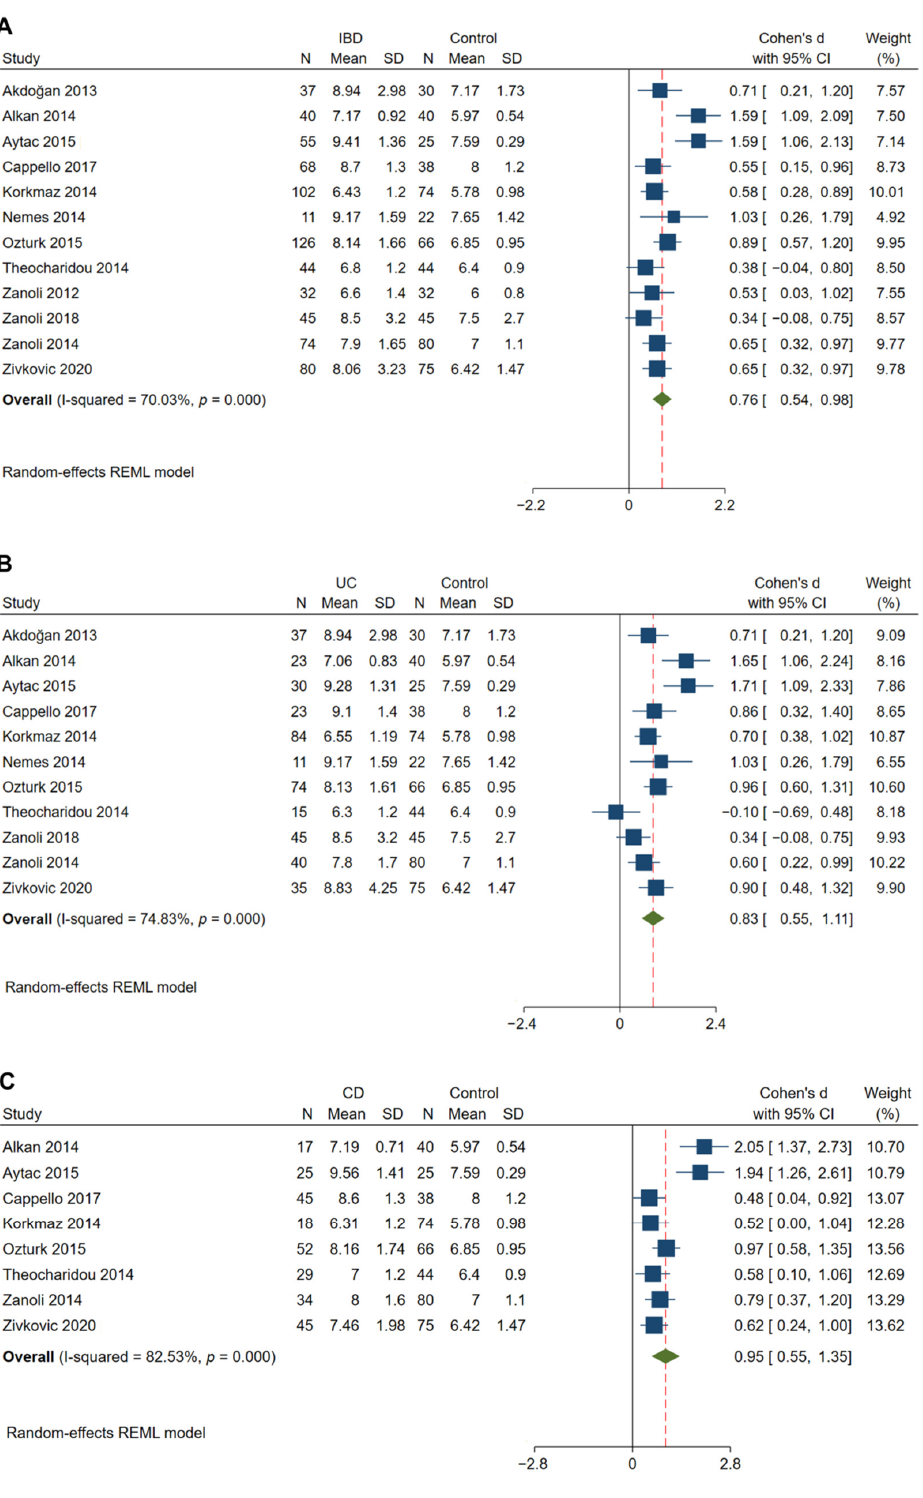
Figure 3. Meta-analysis of studies reporting on cfPWV in patients with IBD compared to matched controls. Comparisons include overall IBD vs. control ( A ), UC vs. control ( B ), and CD vs. control ( C ). cfPWV, carotid-femoral pulse wave velocity.